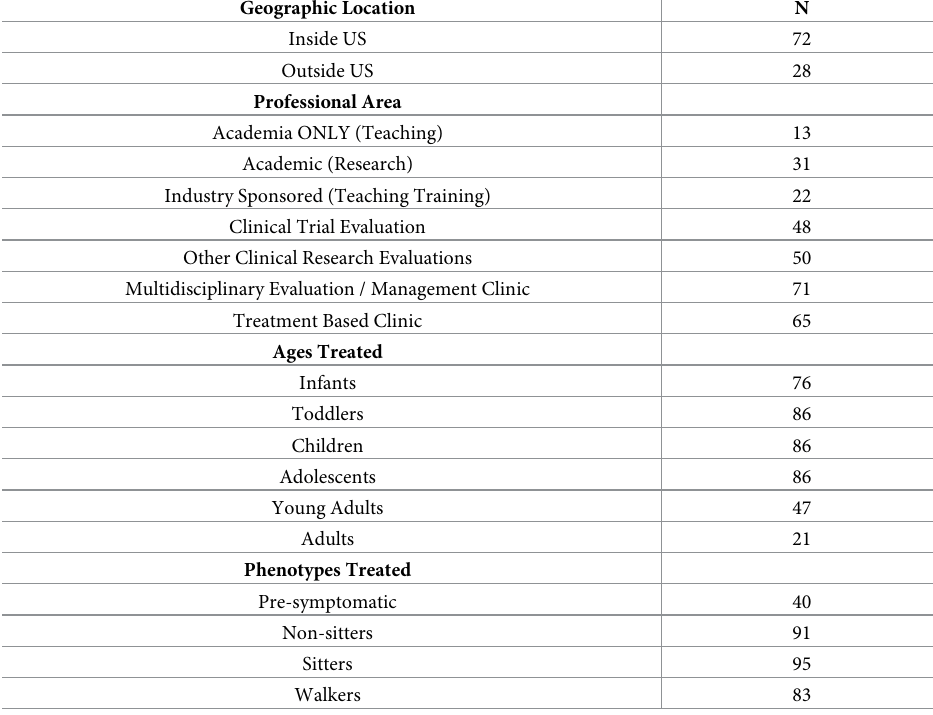
Table 1. Characteristics of